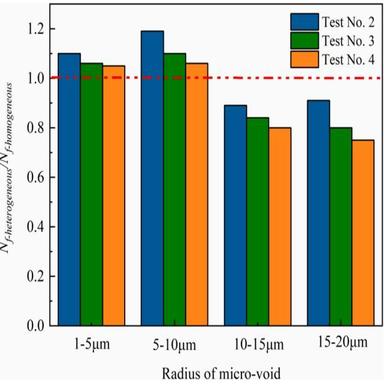
Fretting fatigue lifetime ratio in the models with different sizes of micro-voids in hexagon shape for Test No. 2, 3 and 4.